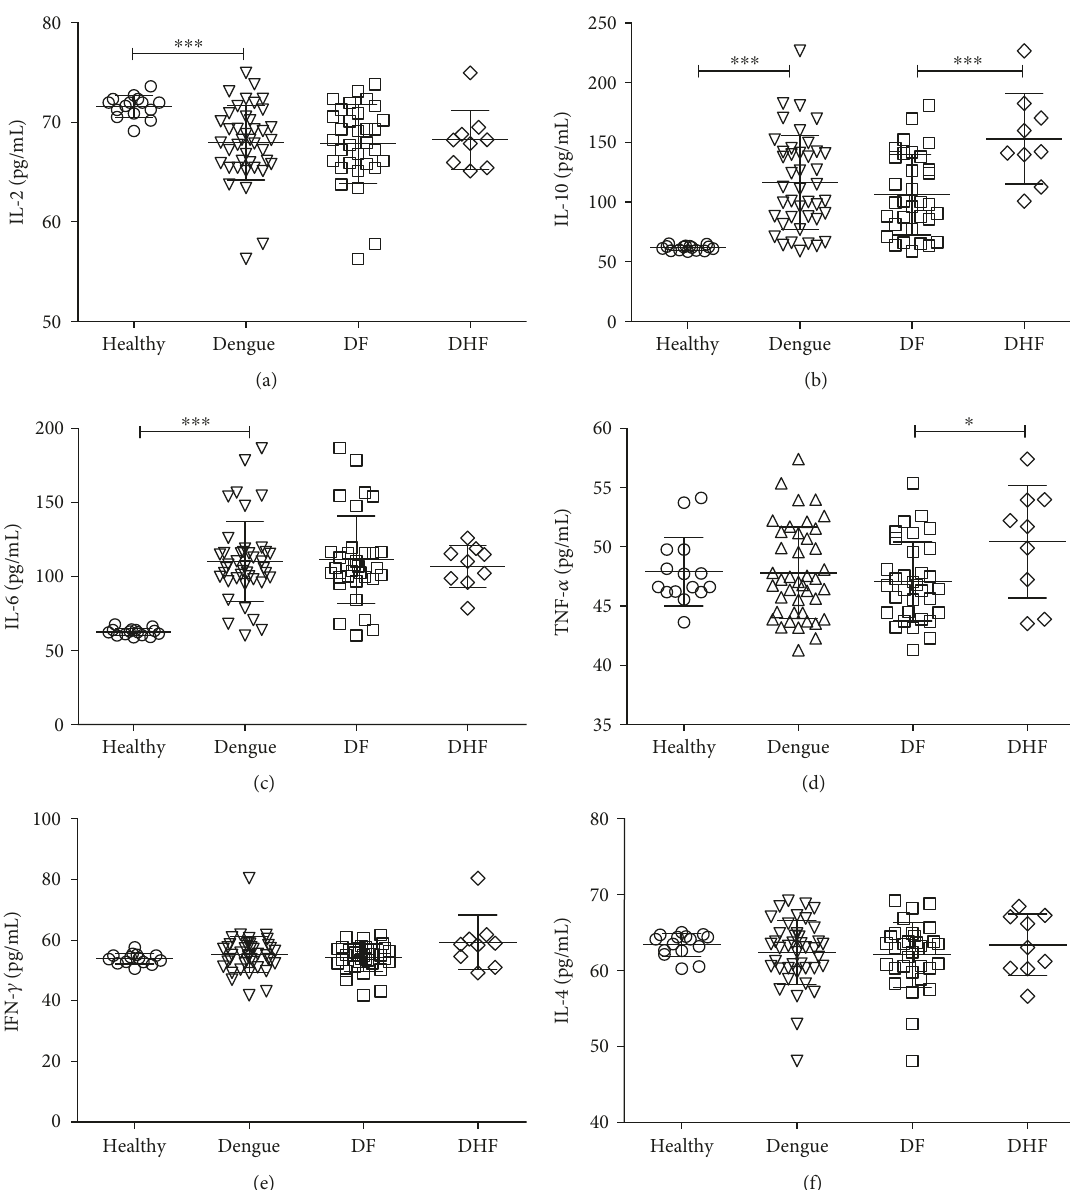
Figure 1: Cytokine concentrations in patients with dengue. Cytokines were determined by cytometric bead array in the blood plasma of the healthy subjects, in all patients with dengue, in DF, and DHF. Results show the values of all subjects belonging to each group; error bars represent mean ± S.D. Signi fi cant di ff erences ∗ P < 0 05 ; ∗∗∗ P < 0 001 by Mann – Whitney U test for continuous